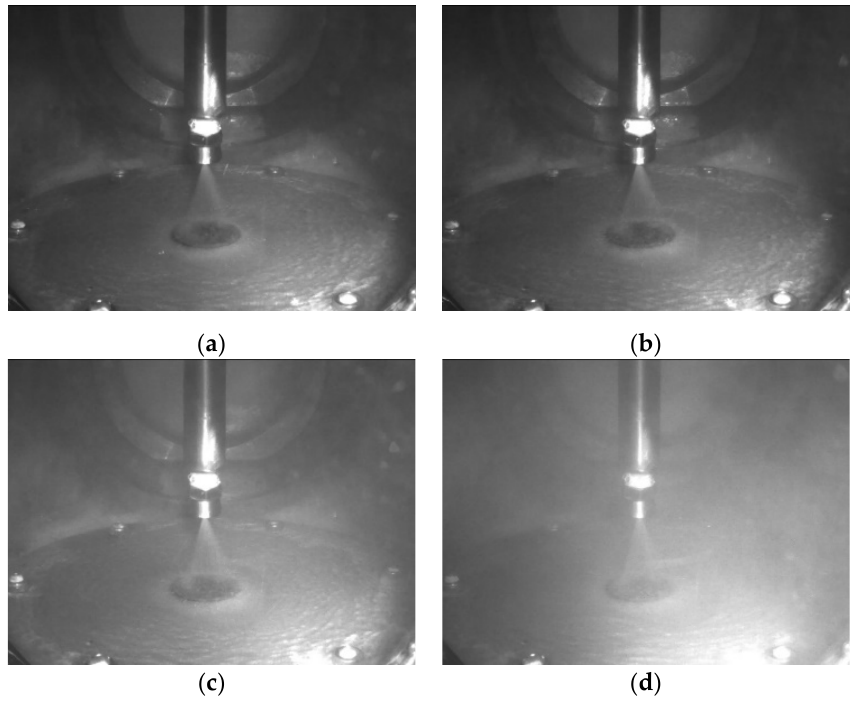
Figure 6. Visualization images of the influence of the change of heating heat flux on the inside of the spray chamber at a flow rate of 40 L/h: ( a ) 50 W/cm 2 ; ( b ) 100 W/cm 2 ; ( c ) 150 W/cm 2 ; ( d ) 200 W/cm 2 .